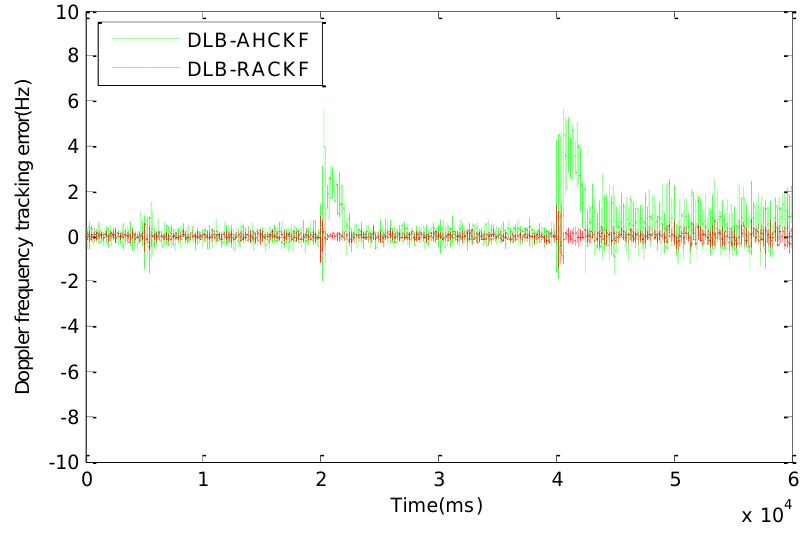
Sensors 2018 , 18 , x FOR PEER REVIEW Figure 4. Comparison of the code phase tracking error among DLB-UKF, DLB-CKF, and DLB-RACKF.